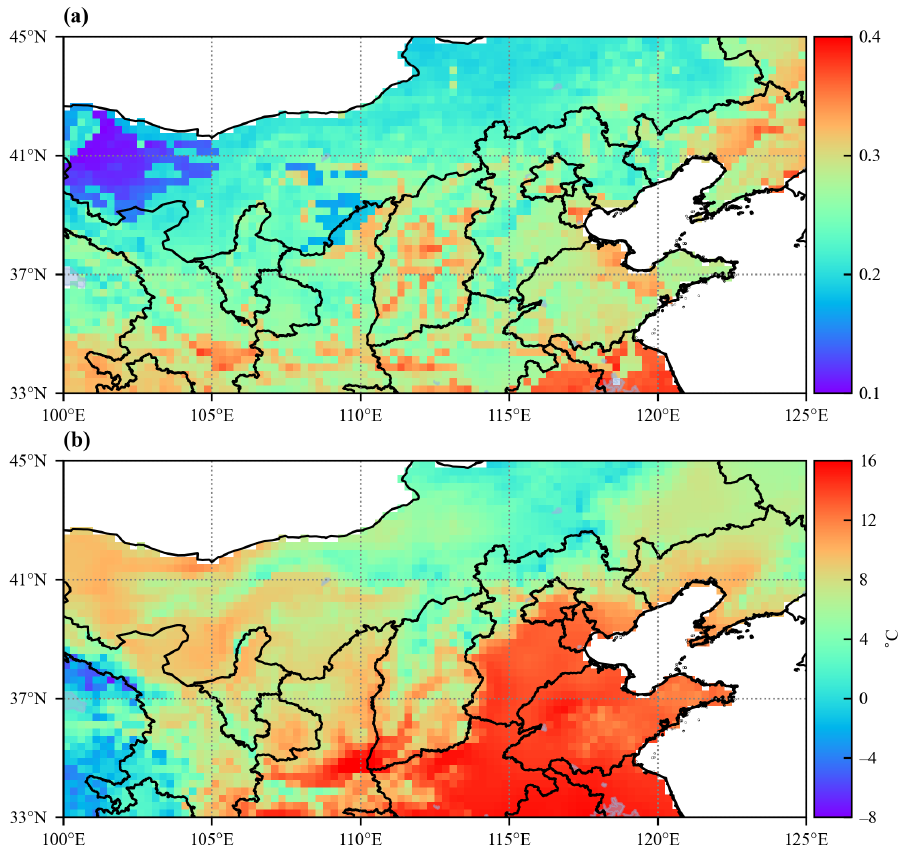
Figure 8. Distribution of climatology of ( a ) soil moisture and ( b ) air temperature in northern China.